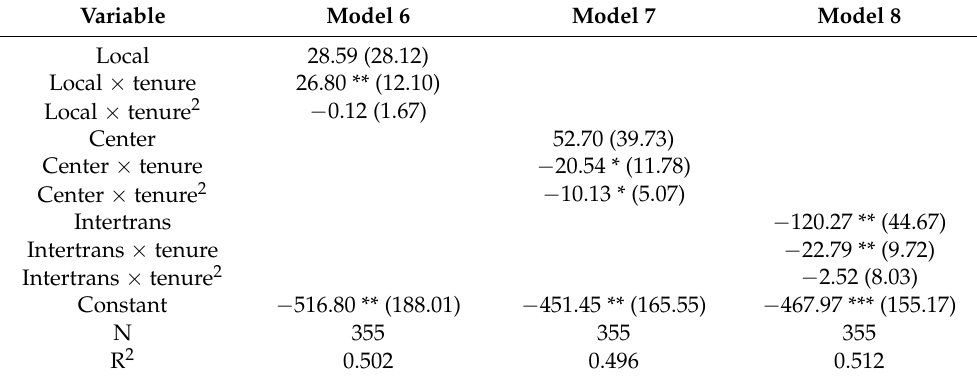
Table 5. Regression results of interaction effects of the variables regarding political